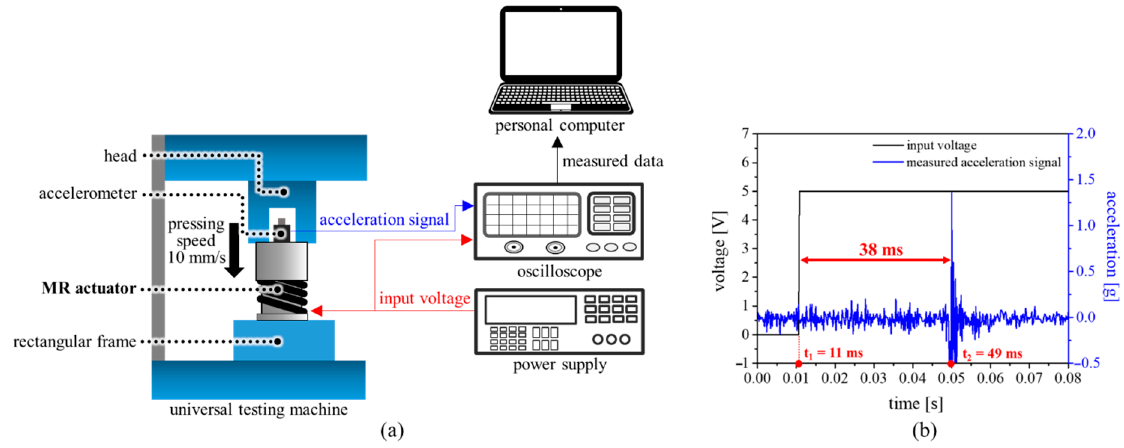
Figure 13. ( a ) Experimental environment and ( b ) the measured response time of the proposed actuator.